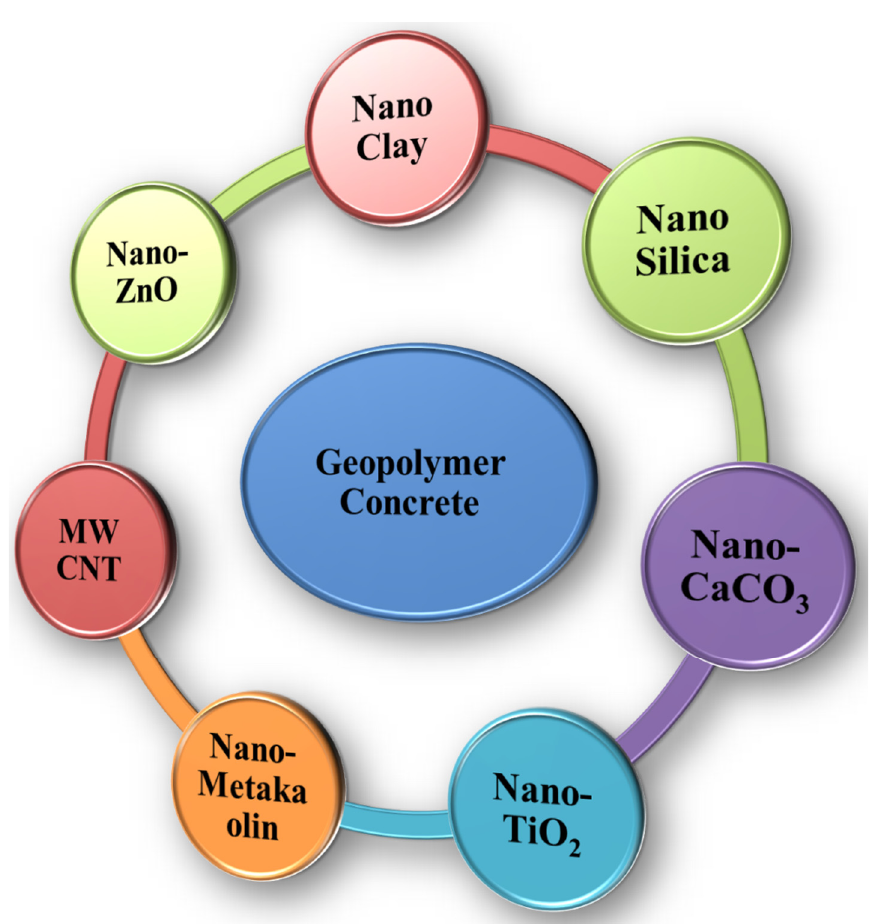
Figure 3. Schematic representation of different nanomaterials used in geopolymer concrete.